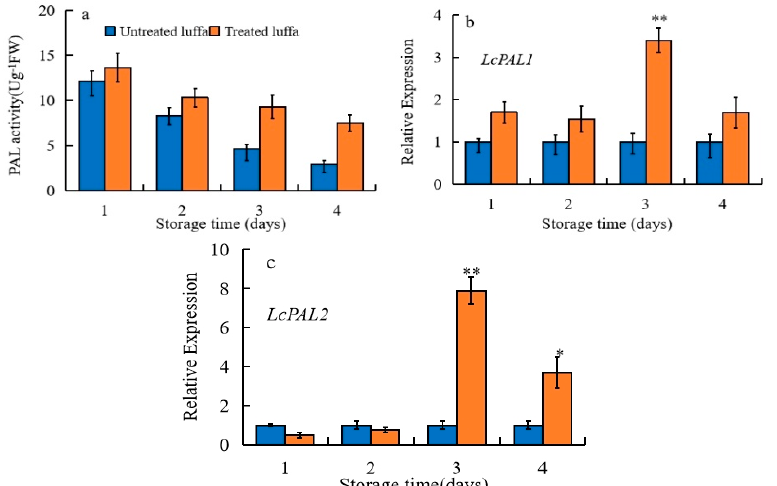
Figure 6. Effect of CaCl 2 treatment on ( a ) phenylalanine ammonia lyase (PAL) activity and ( b , c ) PAL gene expression in fresh-cut luffa. Each value is presented as mean ± SE ( n = 3). ** and * represent extremely significant differences and significant differences, respectively ( p < 0.05 and p < 0.01, respectively). PAL, phenylalanine ammonia lyase.